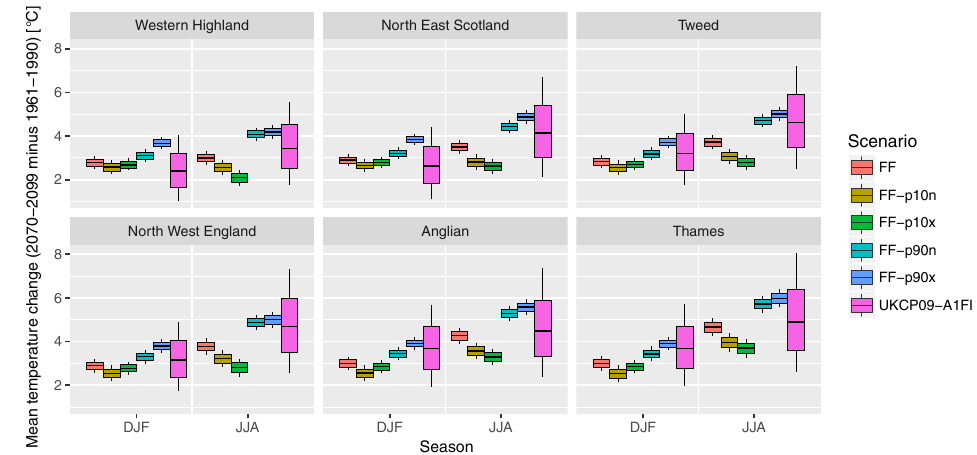
Figure 11. Comparison of temperature projections with UKCP09: for each region, boxes show changes (2070–2099 minus 1961–1990) in JJA (left boxes) and DJF (right boxes) in the five sets of MaRIUS time series and in UKCP09 (high emission scenario: SRES A1FI; 10000 values available). Whiskers display the 10–90% range from each group. See Fig. S14 for the plots for all